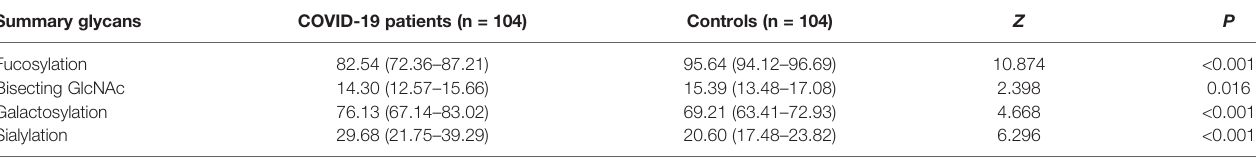
TABLE 2 | Relative abundance (%) of the main IgG glycome features in COVID-19 patients and the healthy controls.